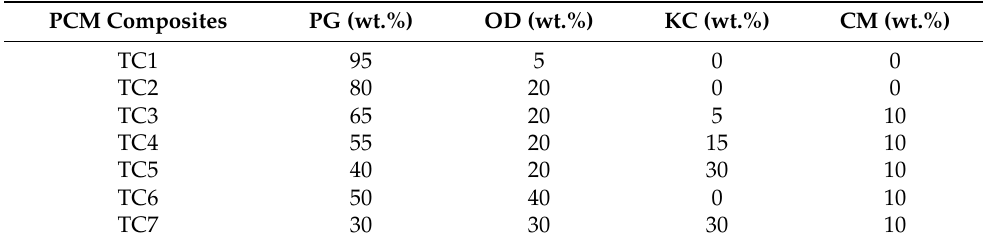
Table 1. Thermal composites (TCs) with various percent